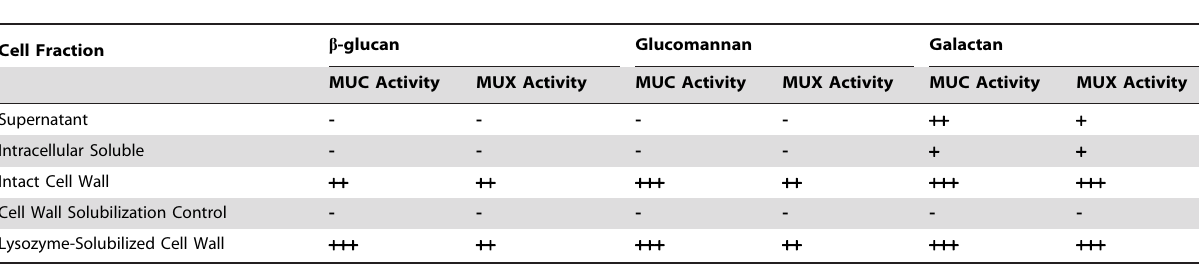
Table 11. Localization of Enzymatic Activity in Bcell.